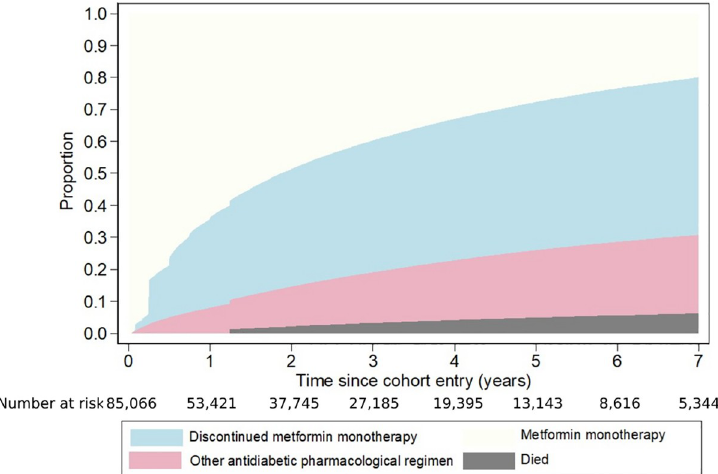
Fig 1. Cumulative proportions who discontinued metformin monotherapy at least once, who changed to another antidiabetic regimen, and who died.